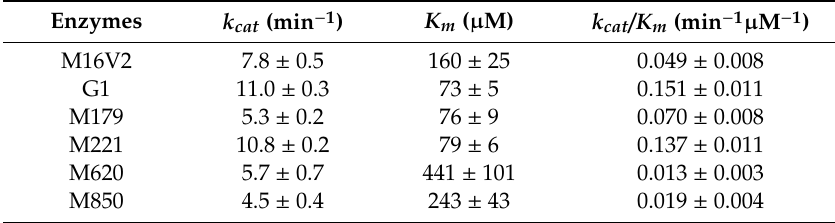
Table 1. Kinetic parameters of naringin DC hydroxylation by CYP102A1. The chimeric mutant M16V2 and selected mutants (G1, M179, M221, M620, and M850).